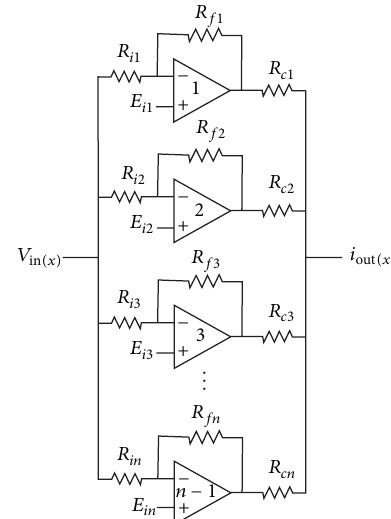
Figure 6: Realization of the SNLF using operational